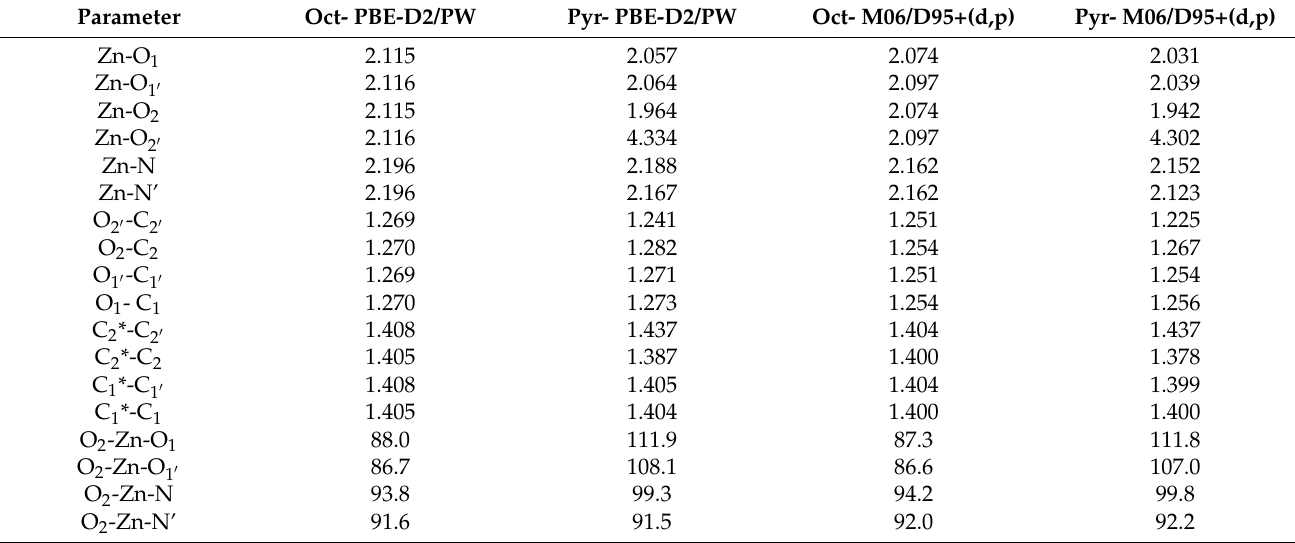
Table 2. Geometrical parameters calculated in the gas phase at 0 K for octahedral (Oct) and pyramidal (Pyr) forms of Zn(hfa) 2 TMEDA at PBE-D2/PW and M06/D95+(d,p) levels (labels in Figure 2). Distances in Å, angles in degrees ( ◦ ).